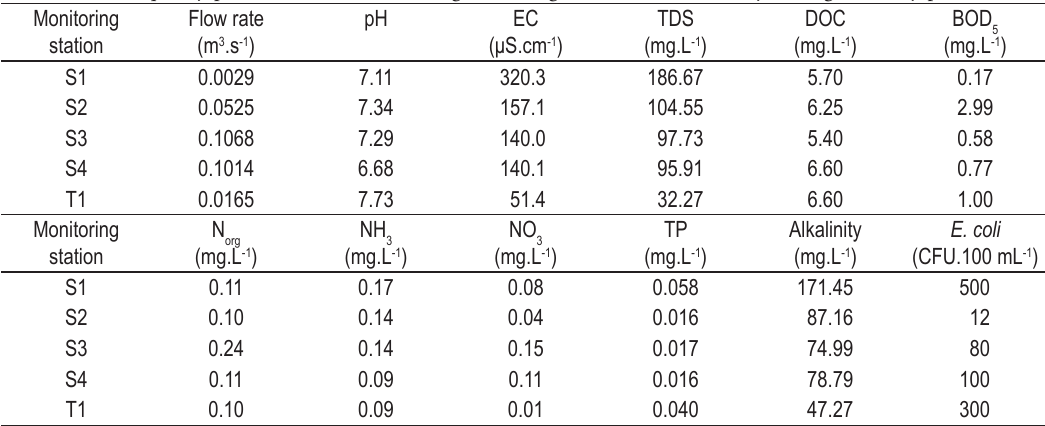
Table 4. Water quality parameters measured along the Fidalgo Stream and tributary during the rainy period.